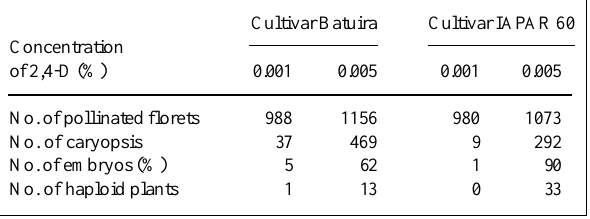
Table II - Effect of 2,4-D concentration on the formation of caryopsis, embryos and haploid plants of two wheat cultivars, using the embryo rescue technique a